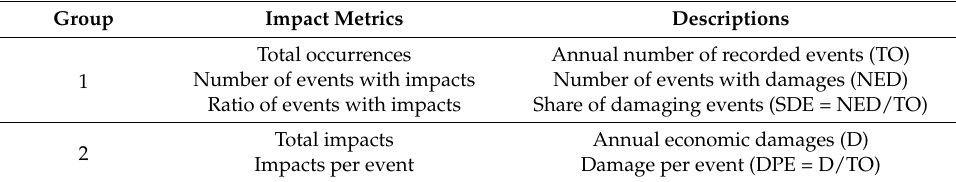
Table 1. Descriptions of impact